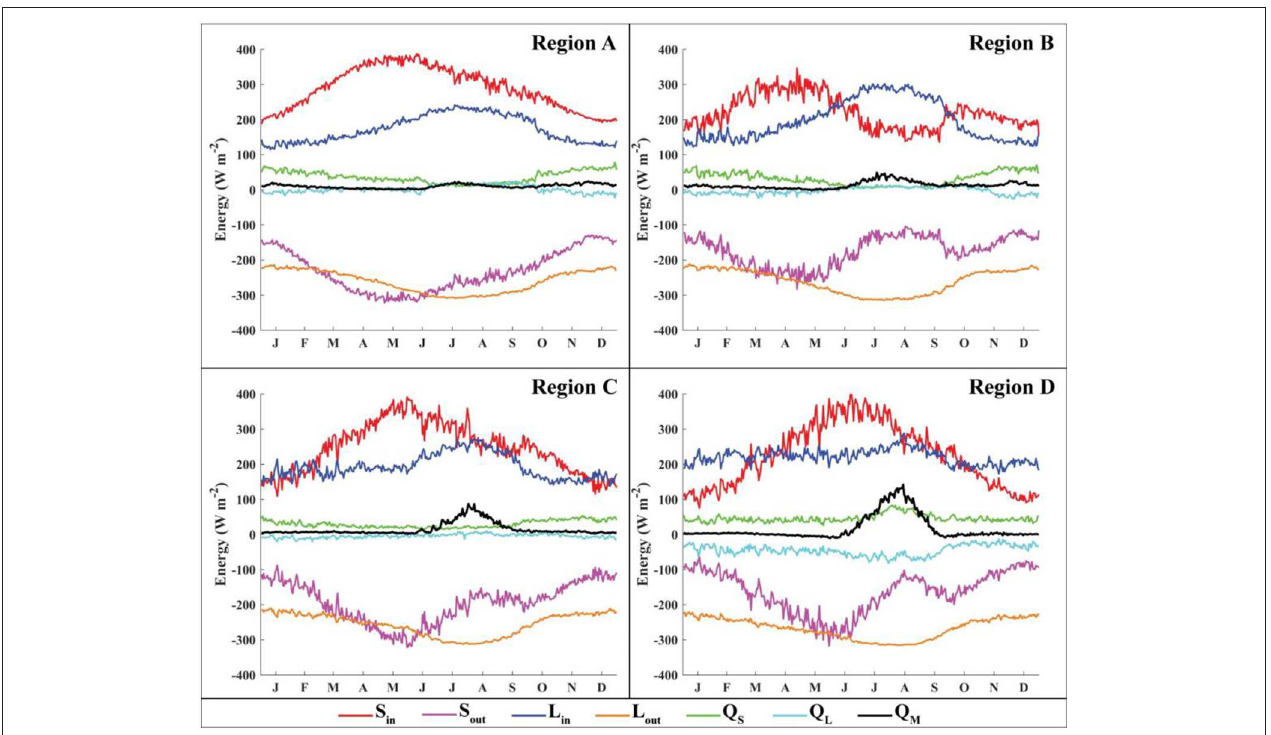
FIGURE 7 | Energy fluxes for the control run averaged over the entire glacier for each day over the 13 years covered by this study. Note that Q G , the heat conducted into the glacier, is not shown here due to its minimal contribution to the overall energy budget. TABLE 2 | Summary of energy fluxes ( Figure 7 ) and changes in energy fluxes due to a + 1 ◦ C temperature change ( Figure 8 ). Region A Region B Region C Region D Control Difference Control Difference Control Difference Control